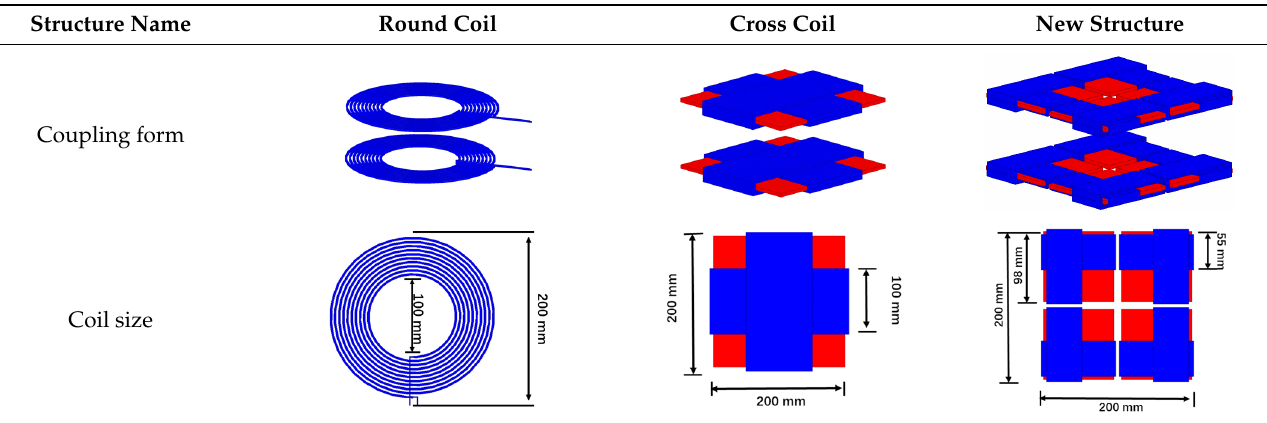
Table 1. Structural parameters of the simulated coil model.